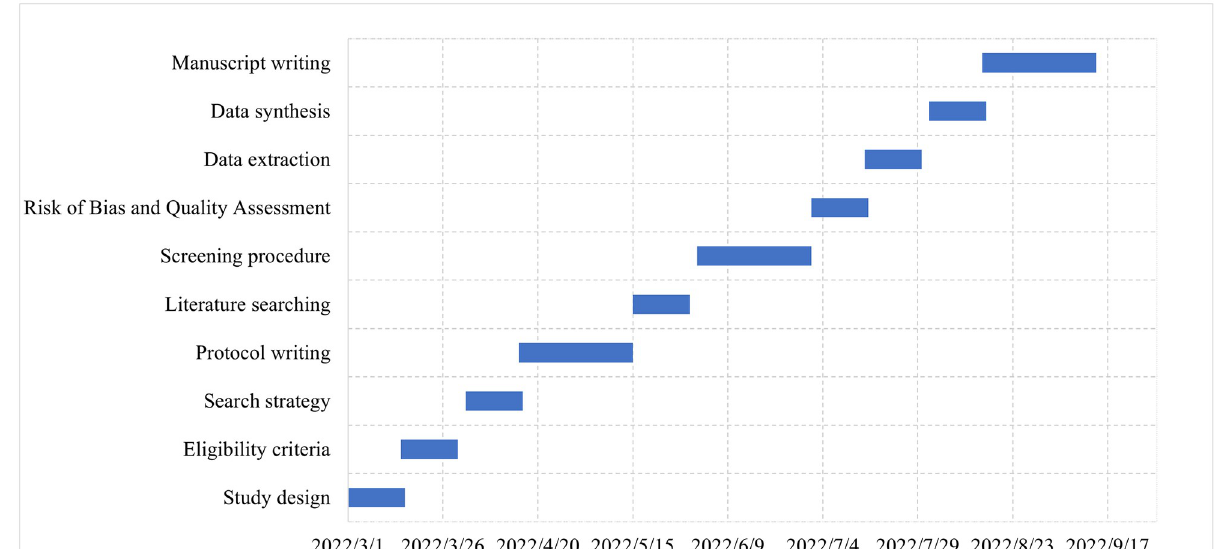
Fig 3. The Gantt chart of the status and timeline of the